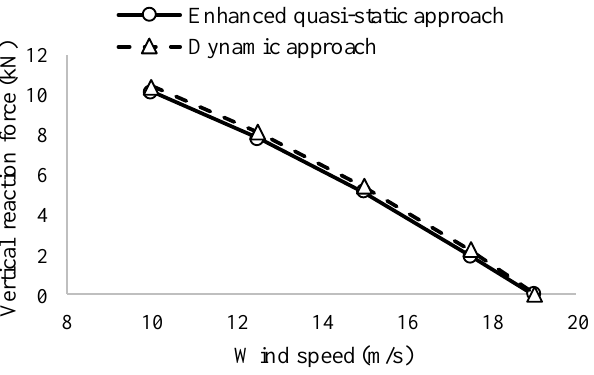
Figure 10. Windward vertical reaction force of the trailer by the enhanced quasi-static approach.